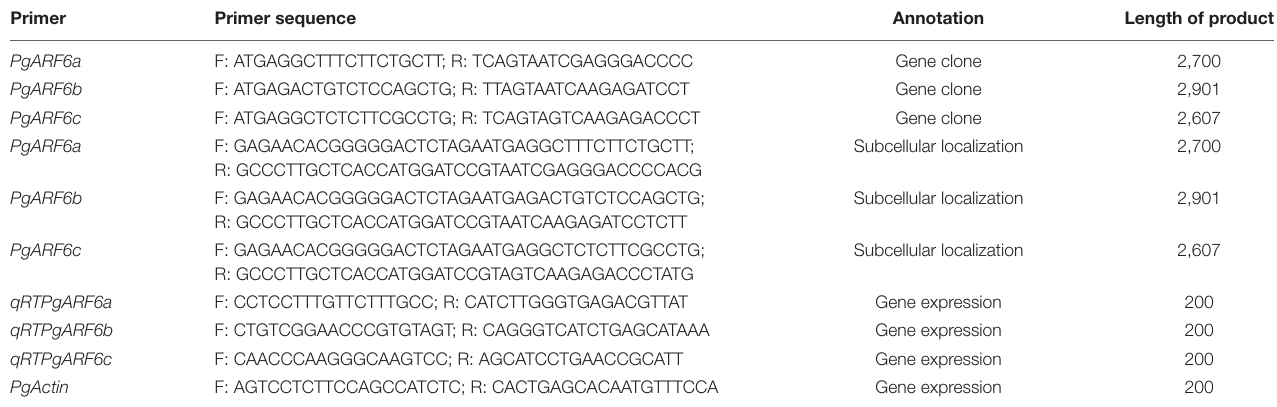
TABLE 1 | Primers for the gene cloning, subcellular localization, and expression analysis. Primer Primer